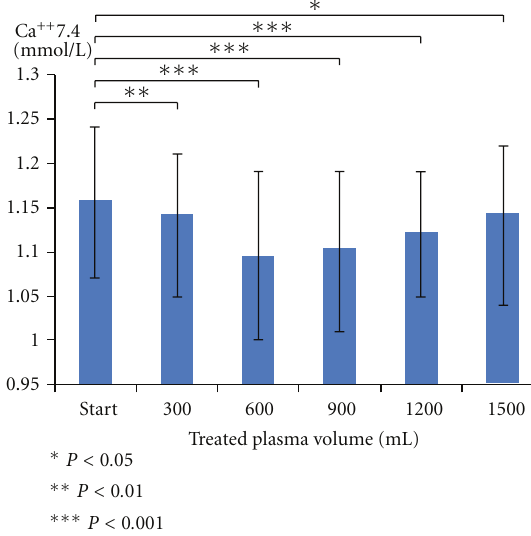
Figure 12: The change of serum Ca ion level during immunoad- sorption with Immusorba TR-350. Reduction of Ca ion level could be observed during treatment by using Immusorba TR-350, because positive ion could be absorbed by the negative charge.